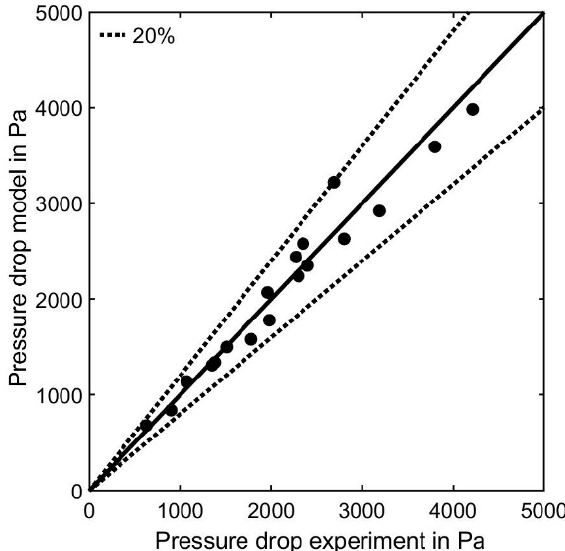
Figure 9. The comparison between the pressure loss in the mathematical model and the experiment with different systems.